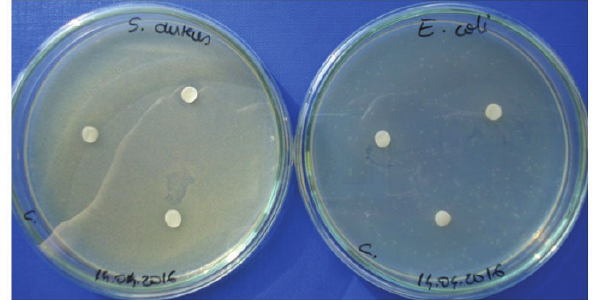
Figure 1: Determination of bacterial sensitivity (A - Staphylococcus aureus , B - Escherichia coli ) in discs impregnated with A. cepa liquid extract, after 72 hours of incubation.